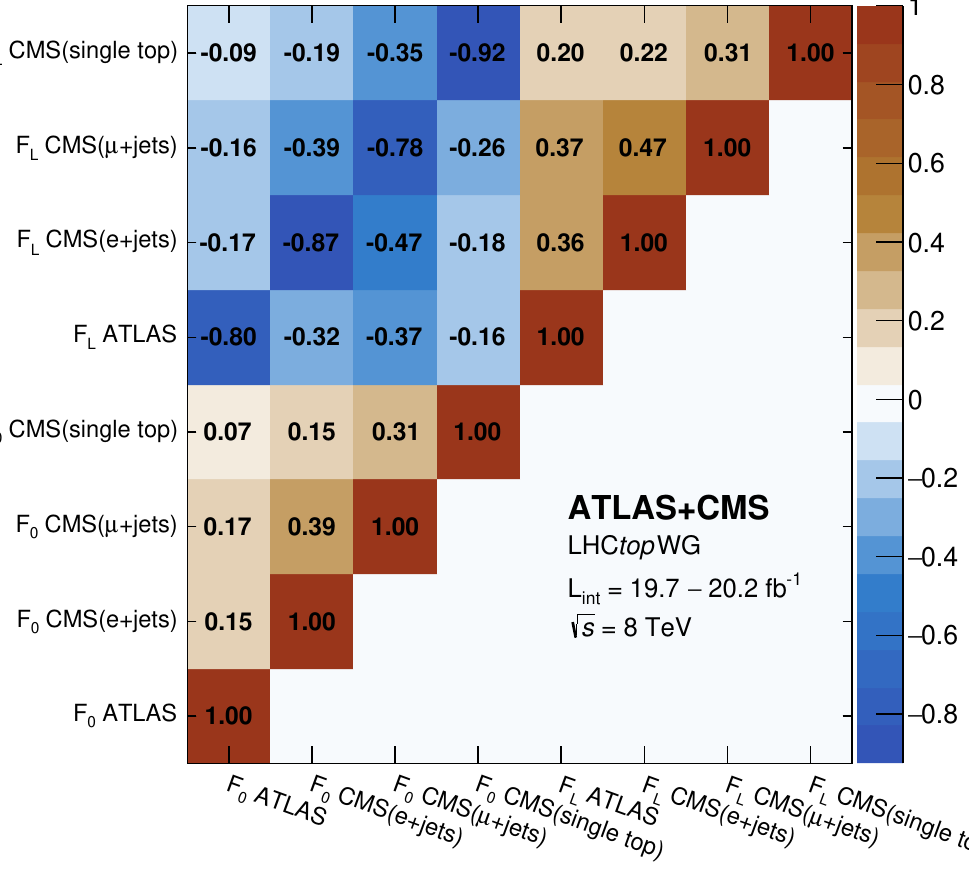
Figure 1 . The total correlation between the input measurements of the combination. linear combination of the input measurements by minimizing the total uncertainty of the combined result, taking into account both the statistical and systematic uncertainties, as well as the correlations between the inputs. In this analysis, the measurements of F and F 0 L are combined while F is obtained as F = 1 (cid:0) F (cid:0) F . As no further constraints on the R R 0 L observables were placed, values outside the range [0, 1] are allowed for the three polarization fractions. The total correlation between F and F obtained from the combination is taken 0 L into account in the estimation of the uncertainty in the F R